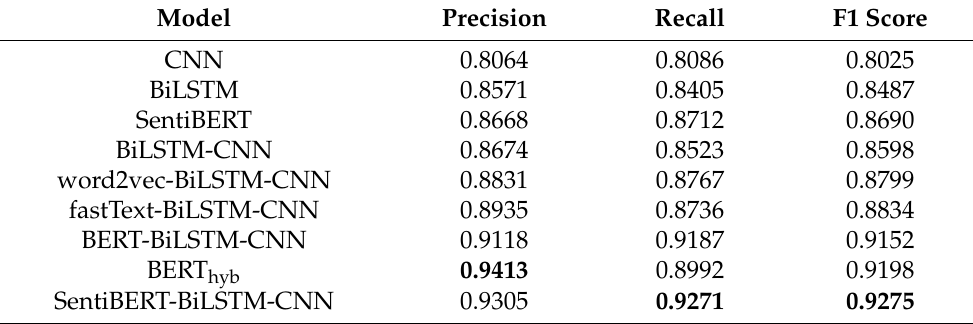
Table 4. A performance comparison of